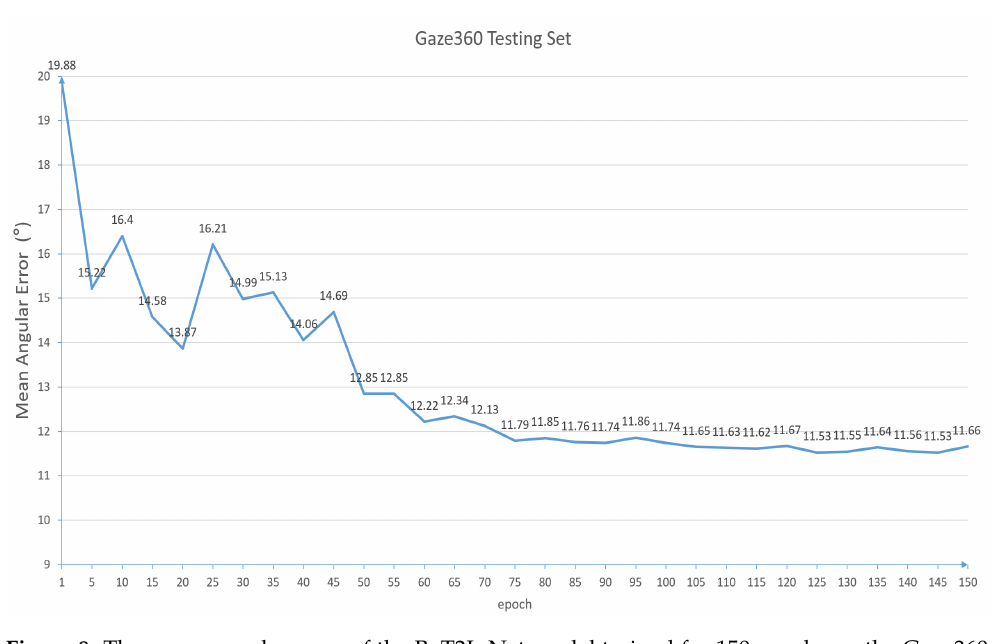
Figure 8. The mean angular error of the BoT2L-Net model trained for 150 epochs on the Gaze360 testing